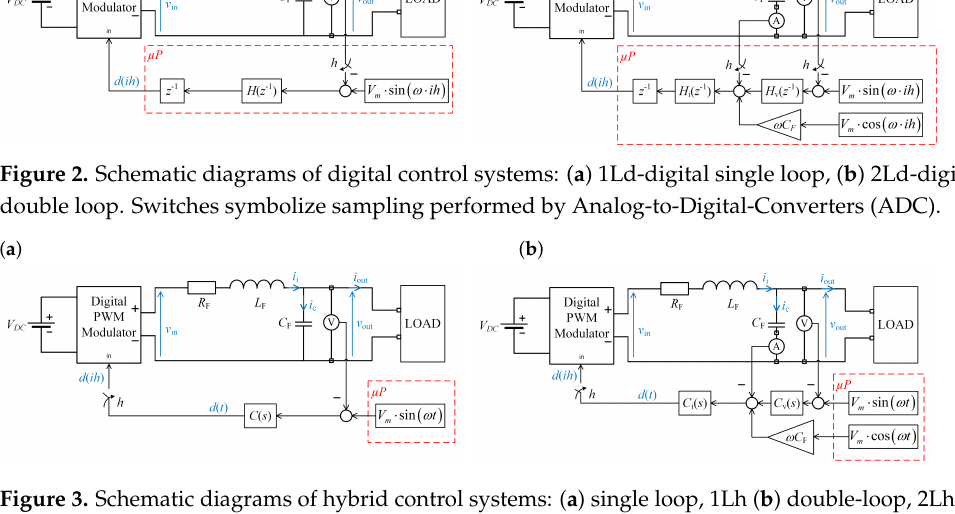
Figure 3. Schematic diagrams of hybrid control systems: ( a ) single loop, 1Lh ( b ) double-loop, 2Lh. It is assumed that the continuous sine wave is produced from the discrete sinusoidal reference passed by a Digital-to-Analog-Converter (DAC) and an analog smoothing filter.